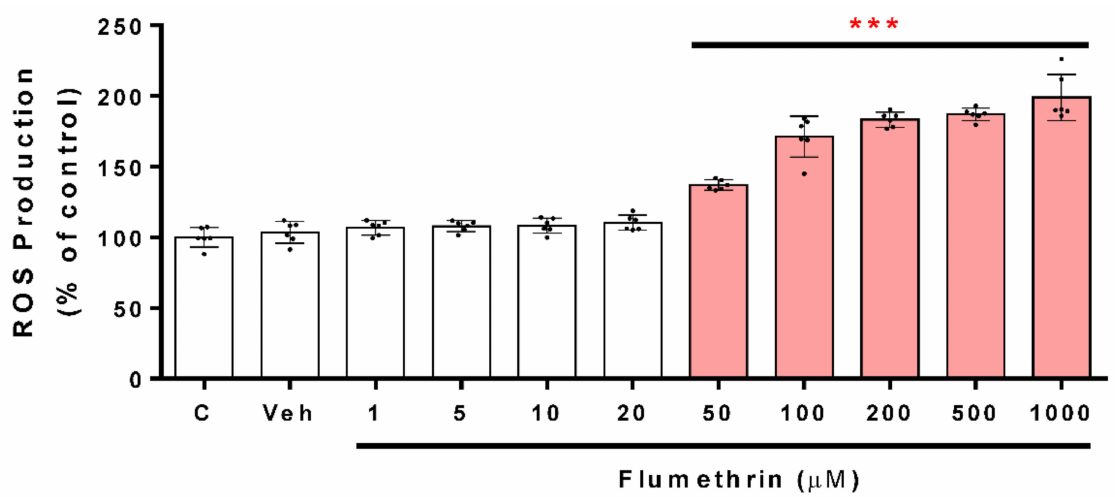
Figure 2. The ROS production induced by flumethrin (1–1000 µ M) in SH-SY5Y cells after a 24 h incubation period. ROS production is expressed as % of control. DMEM-treated cells with 1% FBS were the positive control (c), and cells with 0.1% DMSO were the negative control (Veh). Results are presented as the mean ± SD of six replicates. *** p < 0.001 compared to Veh. A significant increase in intracellular NO could indicate alterations in cellular health.